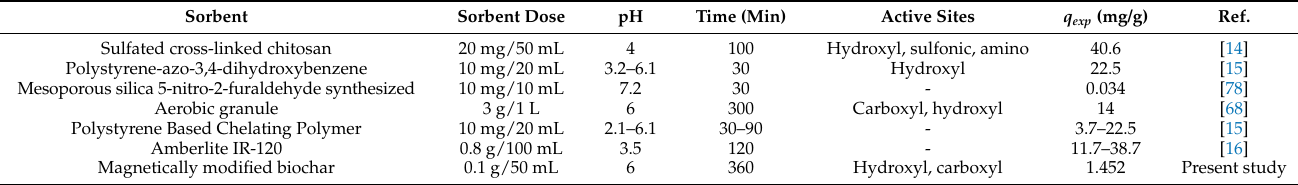
Table 5. The comparison of various types of sorbents for Be(II)